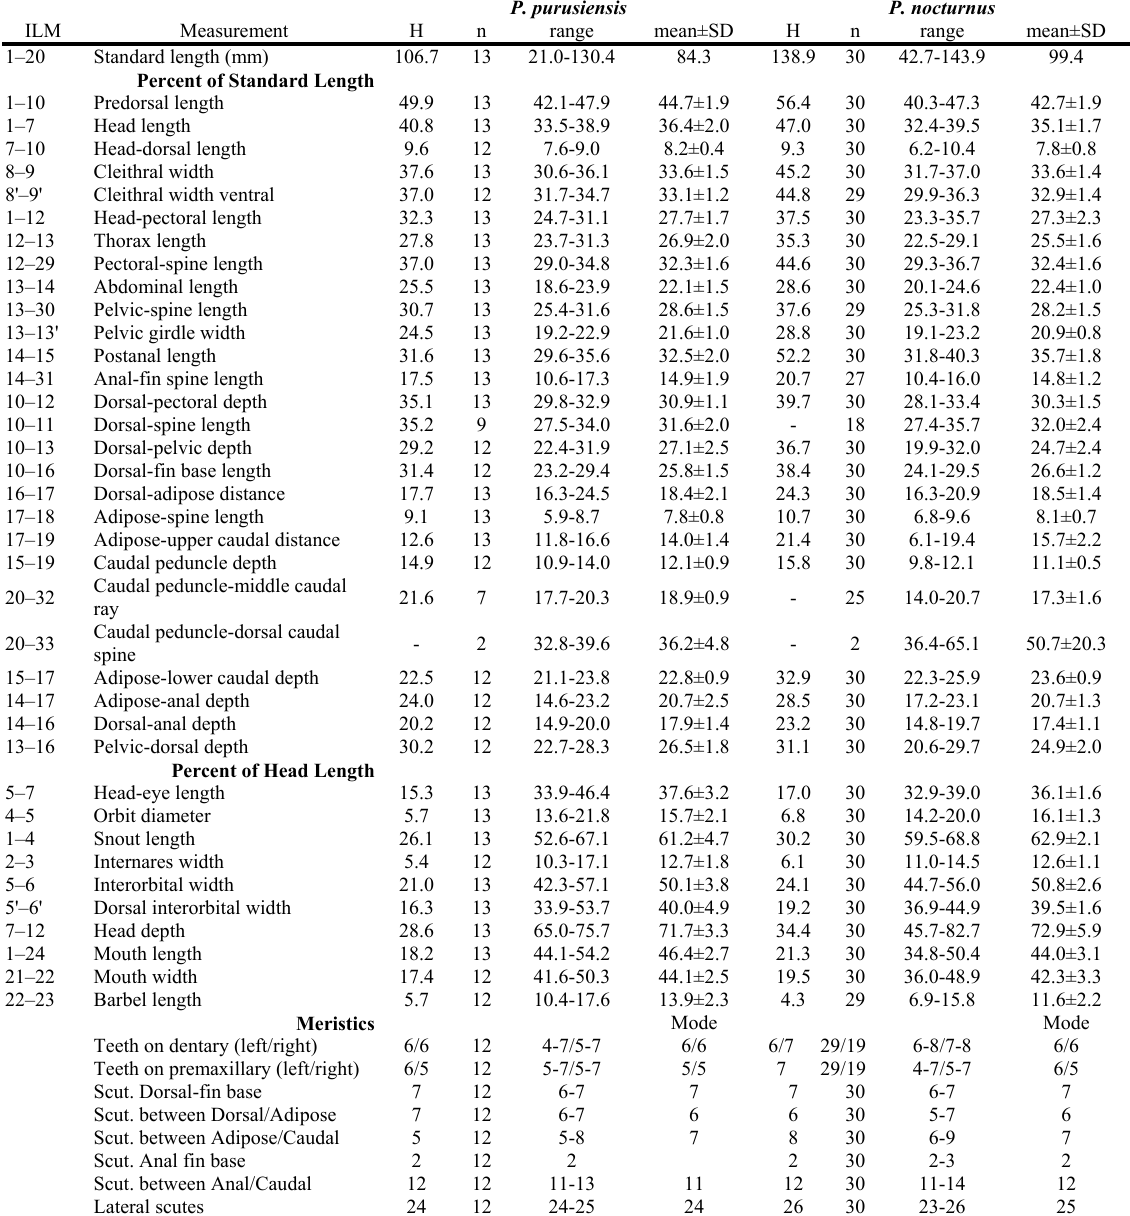
Table 1. Selected morphometric features of Panaqolus purusiensis and P. nocturnus . Values are given as percent of standard length or head length. SD = standard deviation, n = number of specimens, H = holotype. Interlandmarks (ILM) are the two points between which measurements were taken (from Lujan et al .,